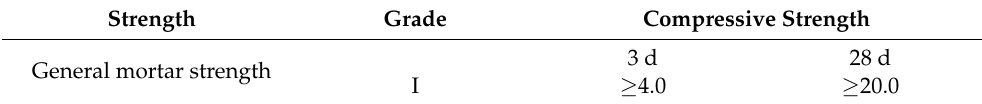
Table 11. General sand strength of solid waste cementitious